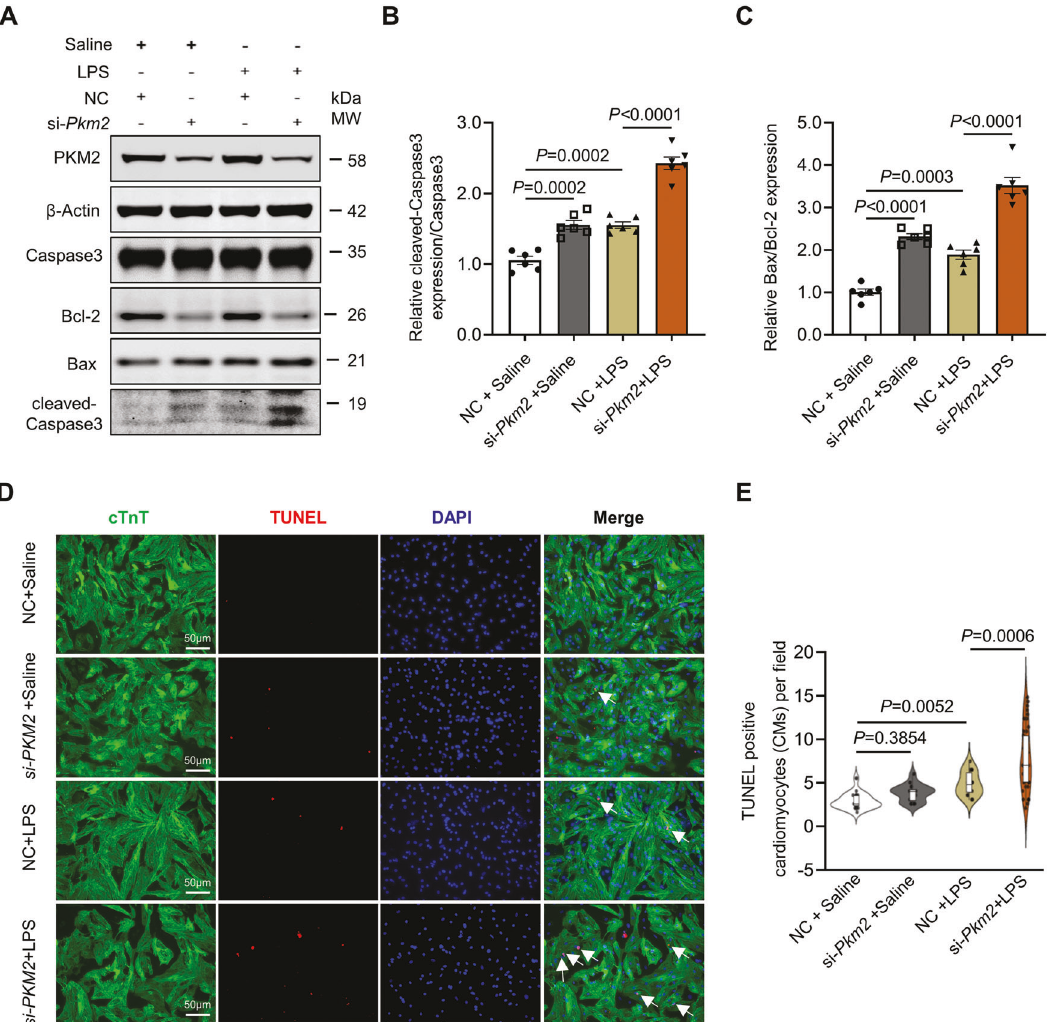
Fig. 2 PKM2 de fi ciency in cardiomyocytes exacerbates LPS-induced cardiomyopathy in vitro. A – C Western blot and quantitation of apoptosis markers (cleaved-Caspase 3/Caspase 3 and Bax/Bcl-2 ratio) expression in NRCMs co-administered with Pkm2 siRNA and LPS. β -Actin served as loading control, n = 6. D , E Representative images and quanti fi cation of TUNEL staining from four groups (NC + Saline, n = 28; si- Pkm2 + Saline, n = 26; NC + LPS, n = 25; si- Pkm2 + LPS, n = 50; scale bar, 50 μ m). White arrows point to TUNEL + cells. NC negative control. Values represent the mean ± SEM of at least three independent